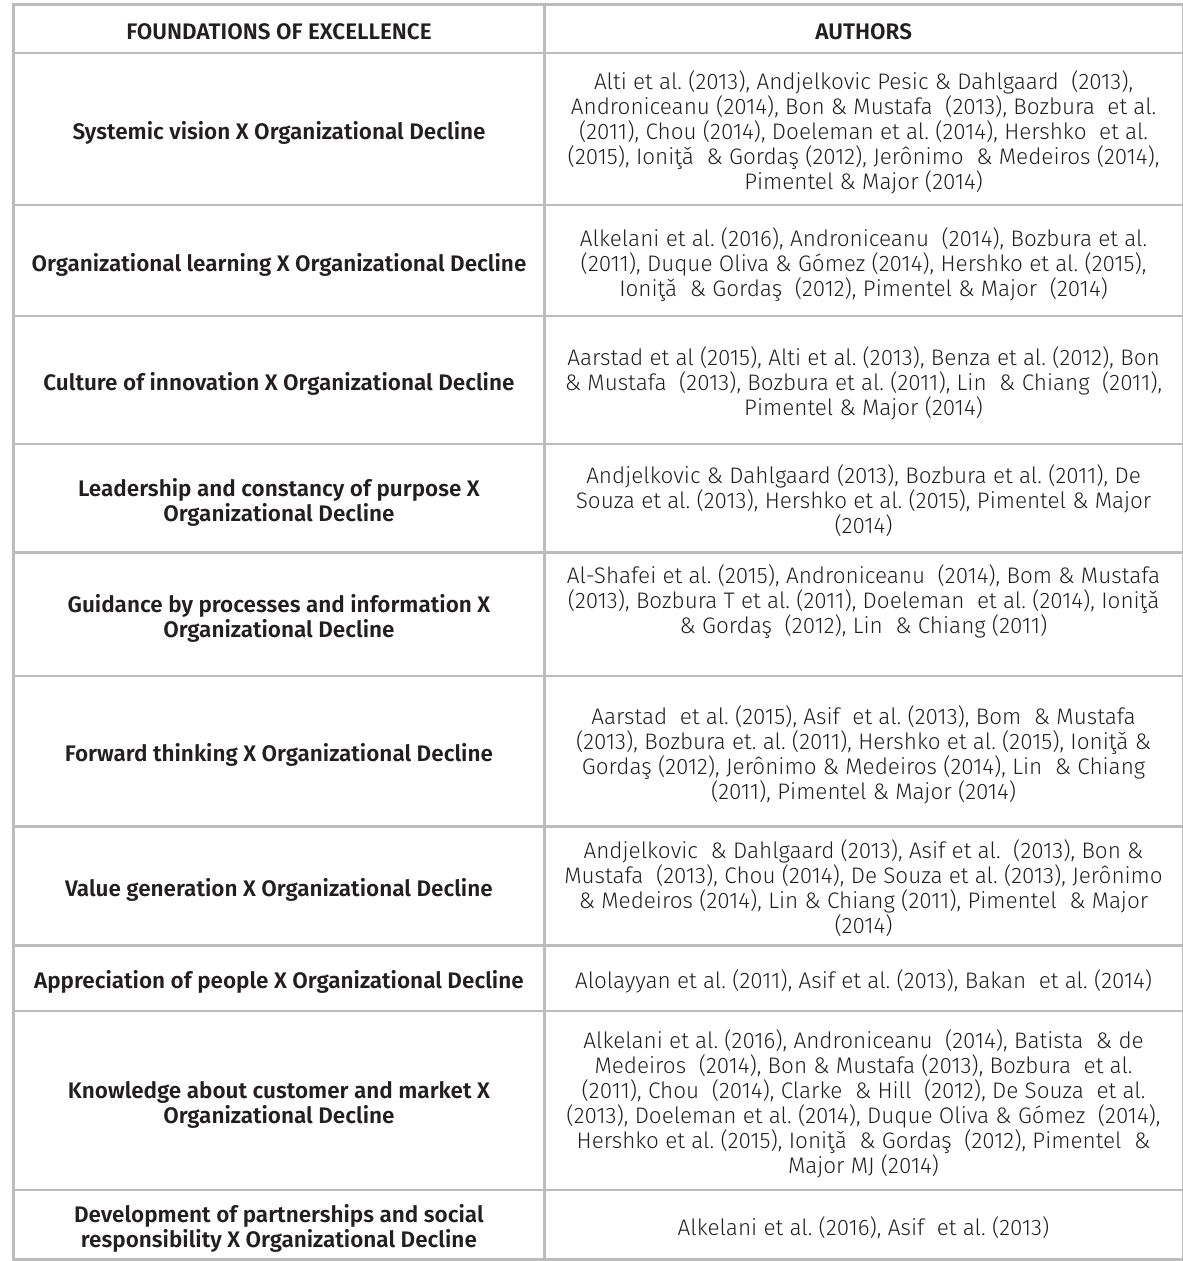
Table IV. List of the Foundations of Quality in Services and Organizational